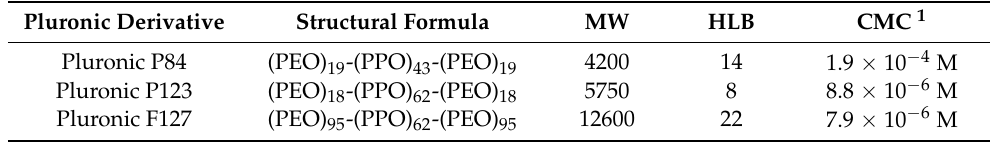
Table 3. HLB and CMC values of Pluronic derivatives used for micelles